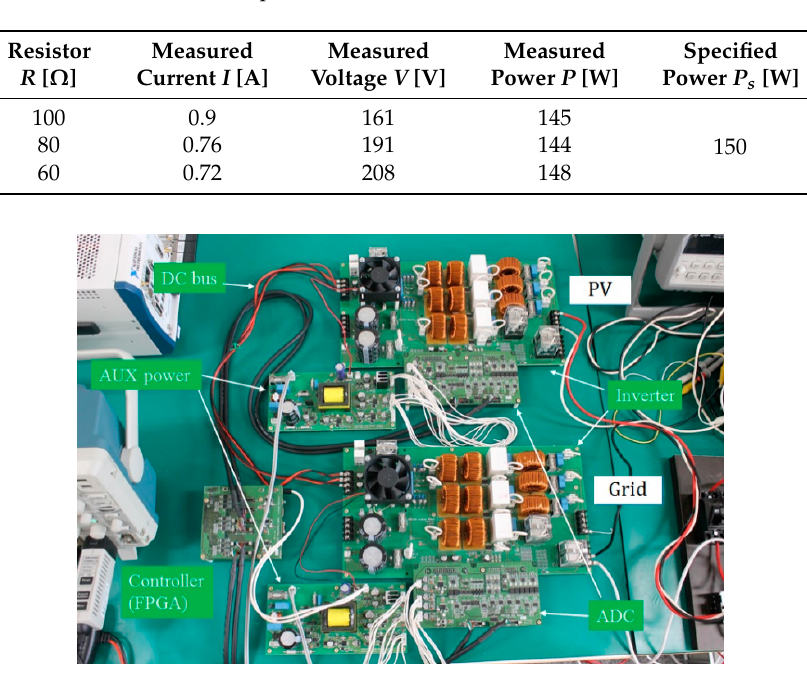
Figure 11. Experimental DGR circuit.